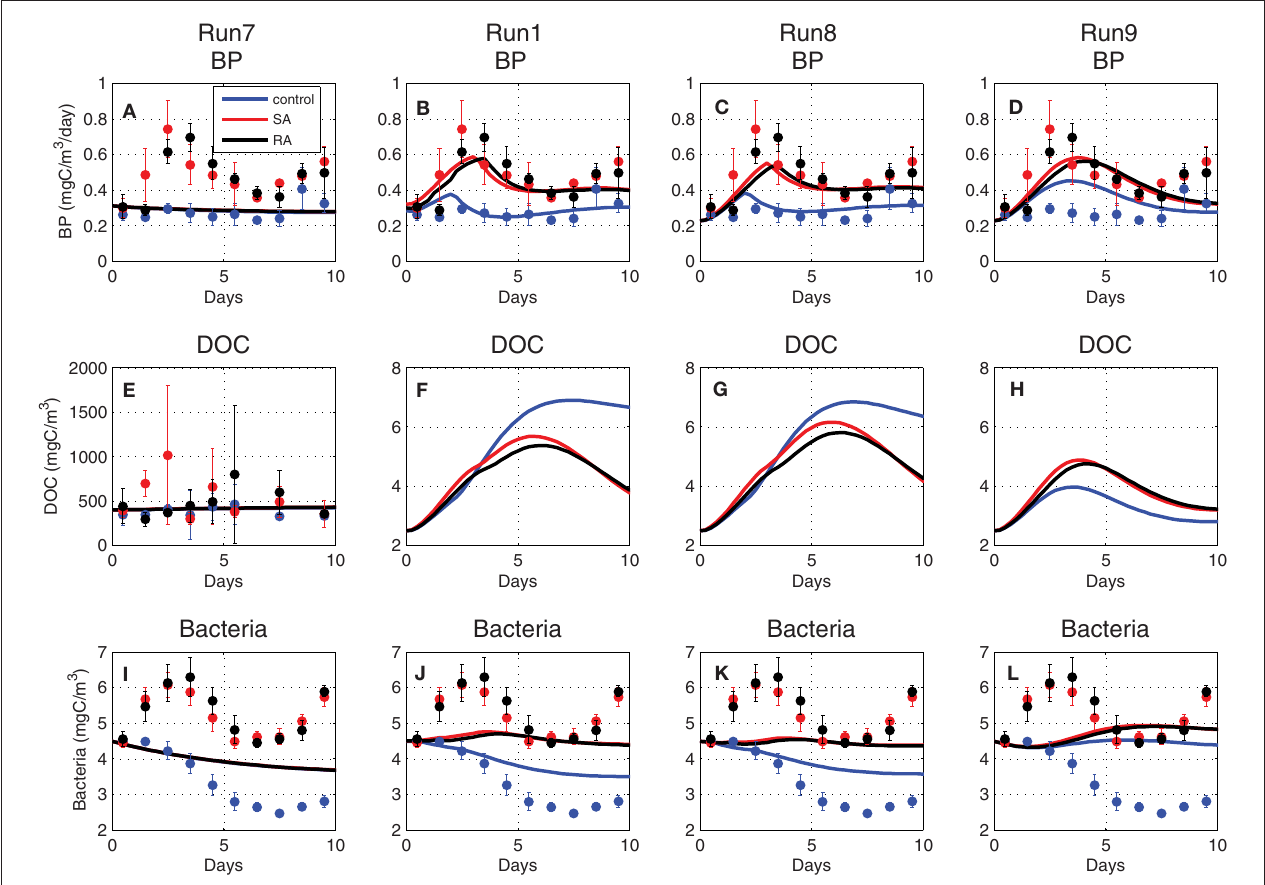
FIGURE 10 | Evolution of (A–D) bacterial production (BP, mgC/m 3 /day), (E–H) dissolved organic carbon (DOC, mgC/m 3 ), and (I–L) bacterial biomass (mgC/m 3 ) simulated in Run7, Run1, Run8, and Run9 (see Table 1 for simulation attributes).